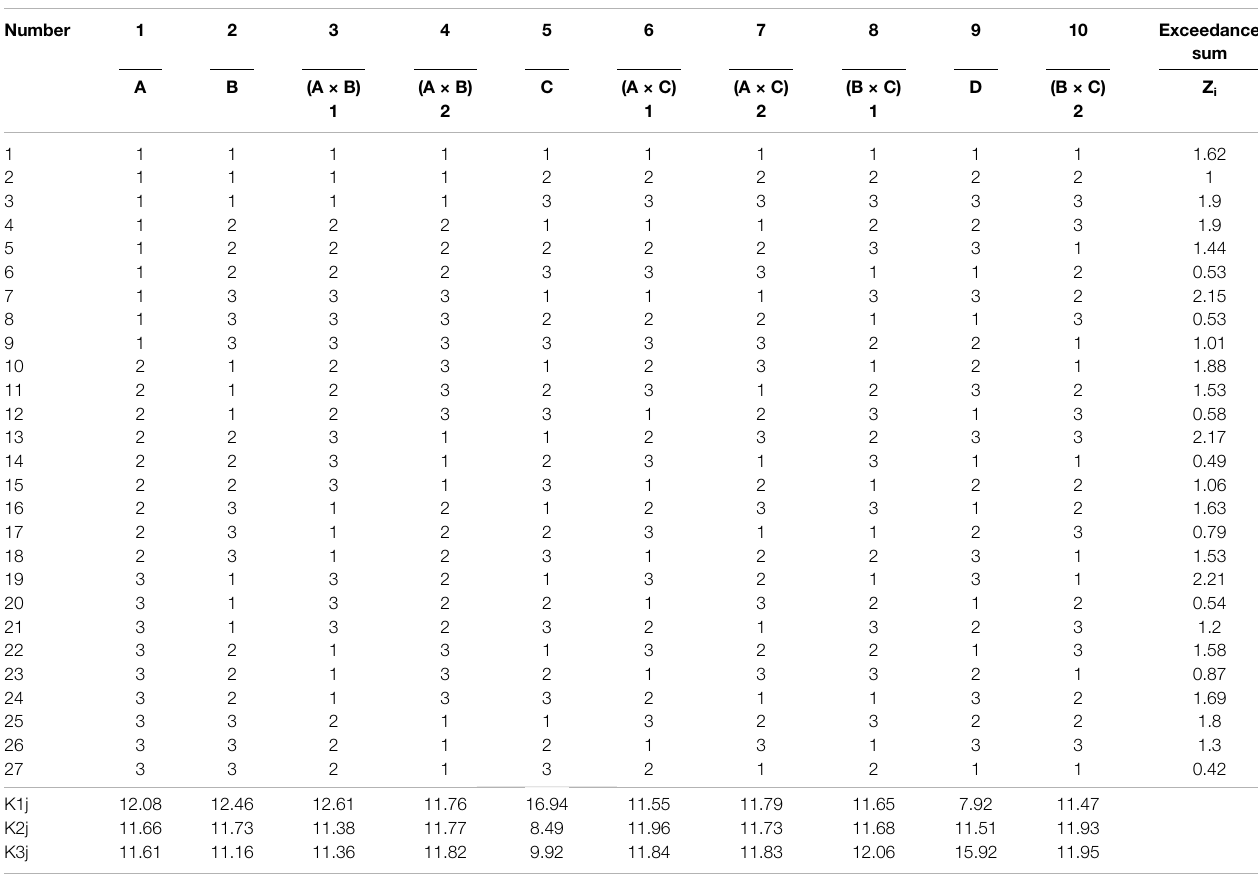
TABLE 7 | Rock stress value.